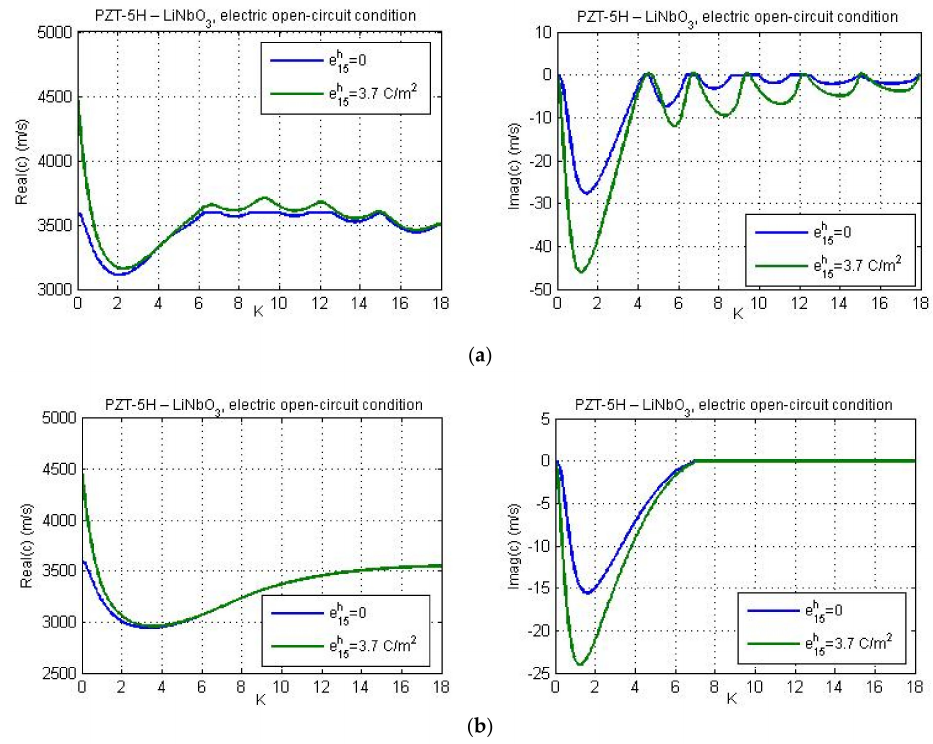
Figure 10. The dispersion curves for the material combination PZT-5H—LiNbO 3 with and without considering the effect of piezoelectric properties of the substrate under electric open-circuit conditions and for guiding layer thickness: ( a ) h = 20 nm and ( b ) h = 40